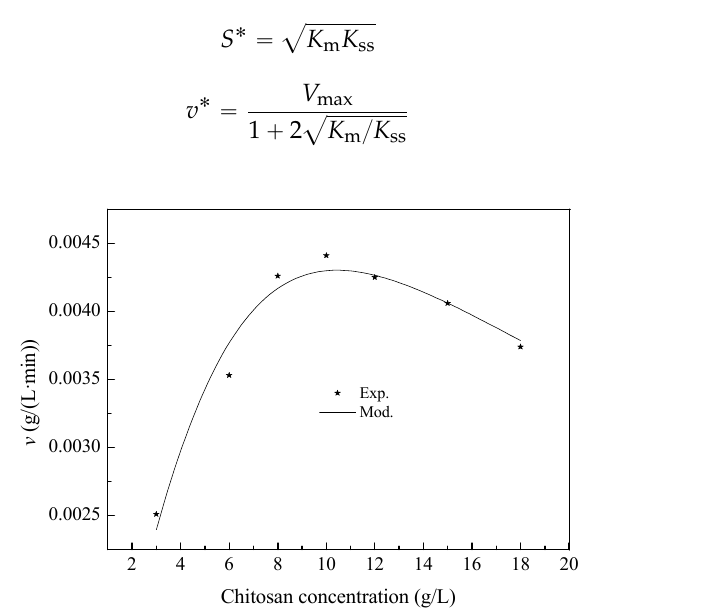
Figure 3. Maximum speci fi c hydrolysis rate for chitosan substrate concentrations from 3.0 to 18.0